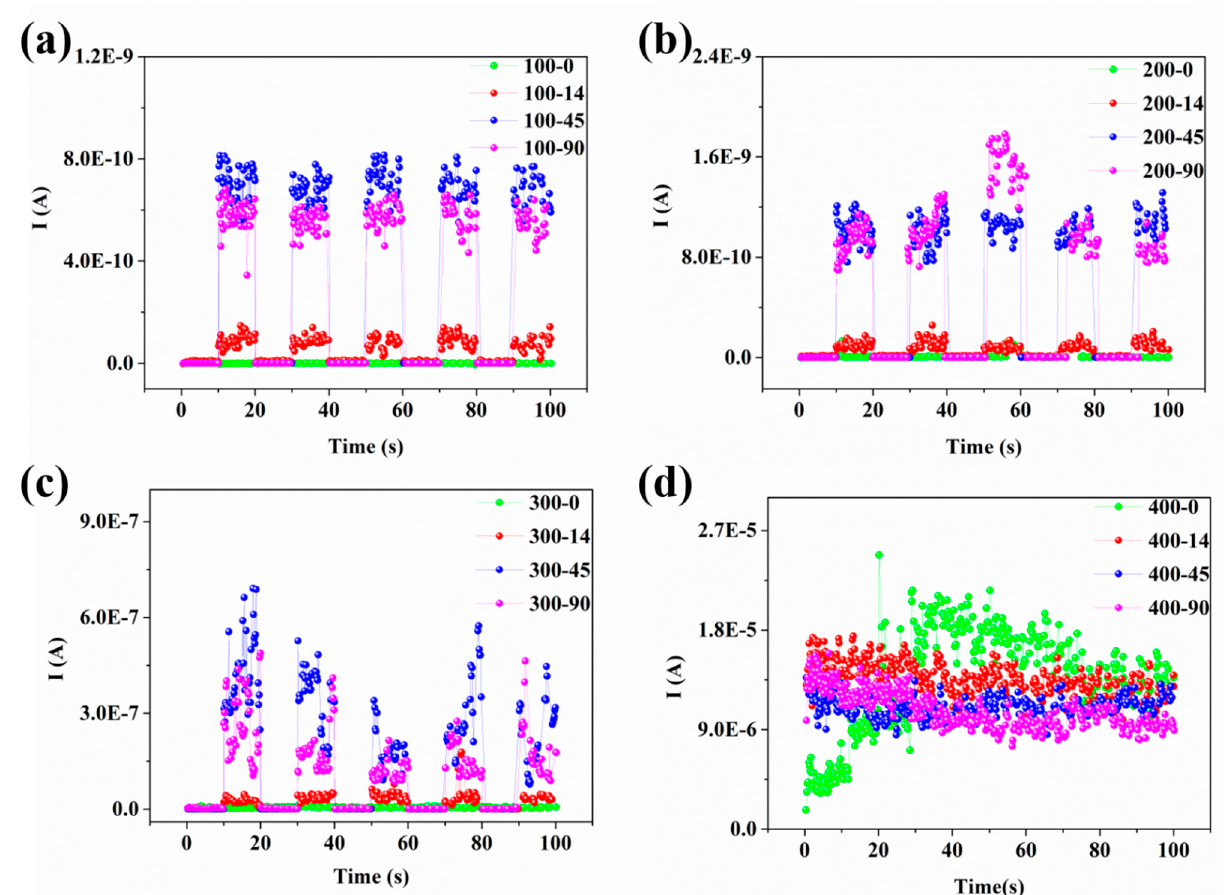
Figure 5. The variation of emission current of the VCNTAs under the different laser power and bias voltage, when the laser is switched on and off. Different colors in each figure represent different excitation laser power, ( a ) at a bias of 100 V, ( b ) at a bias of 200 V, ( c ) at a bias of 300 V, and ( d ) at a bias of 400 V.